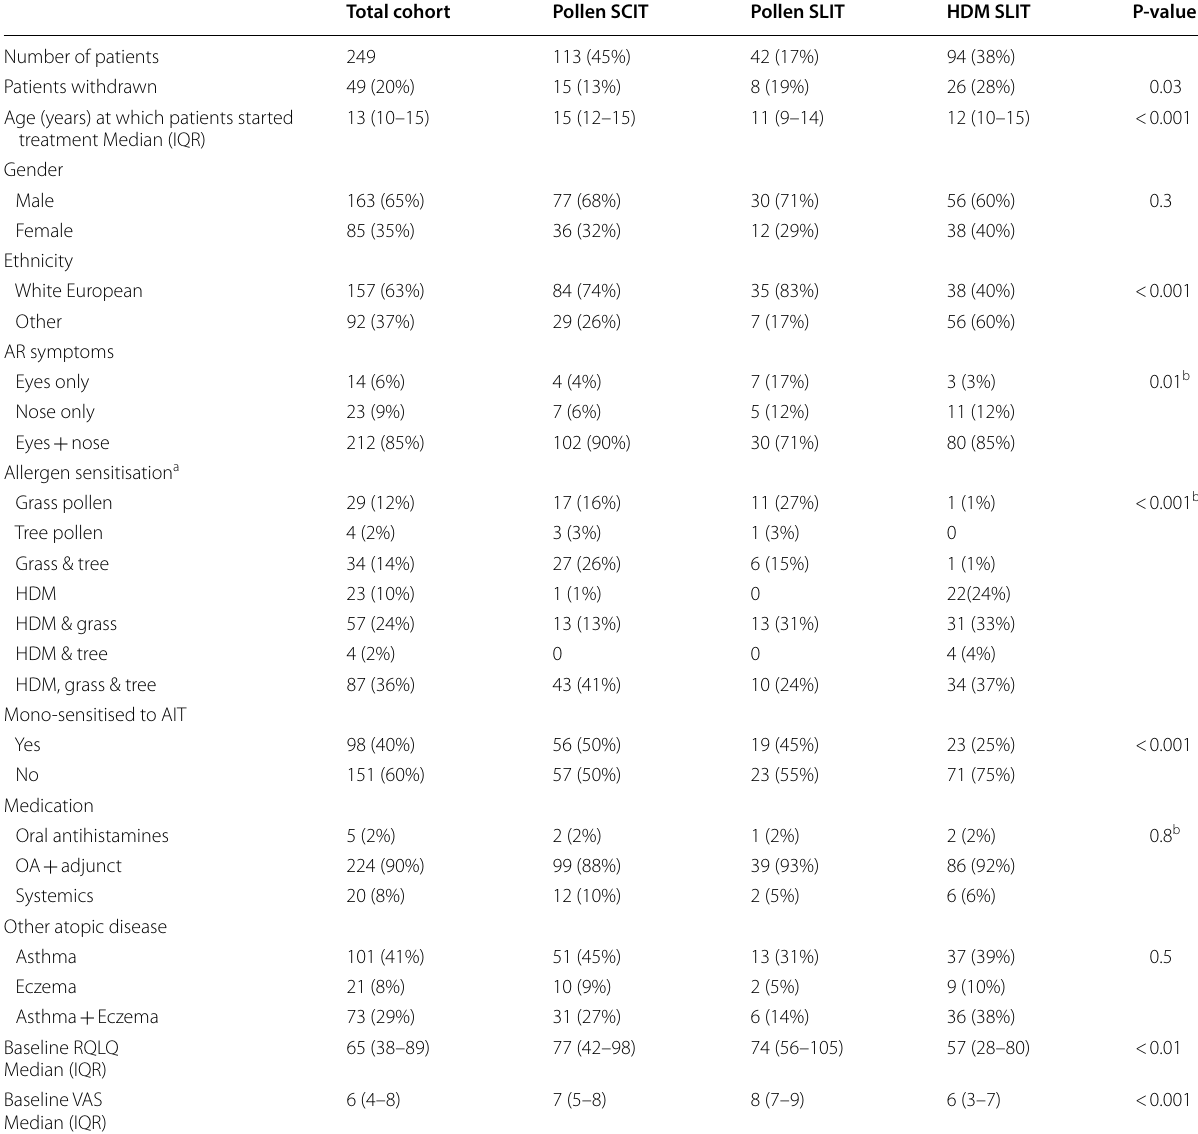
Table 1 Demography and clinical characteristics of total cohort and AIT